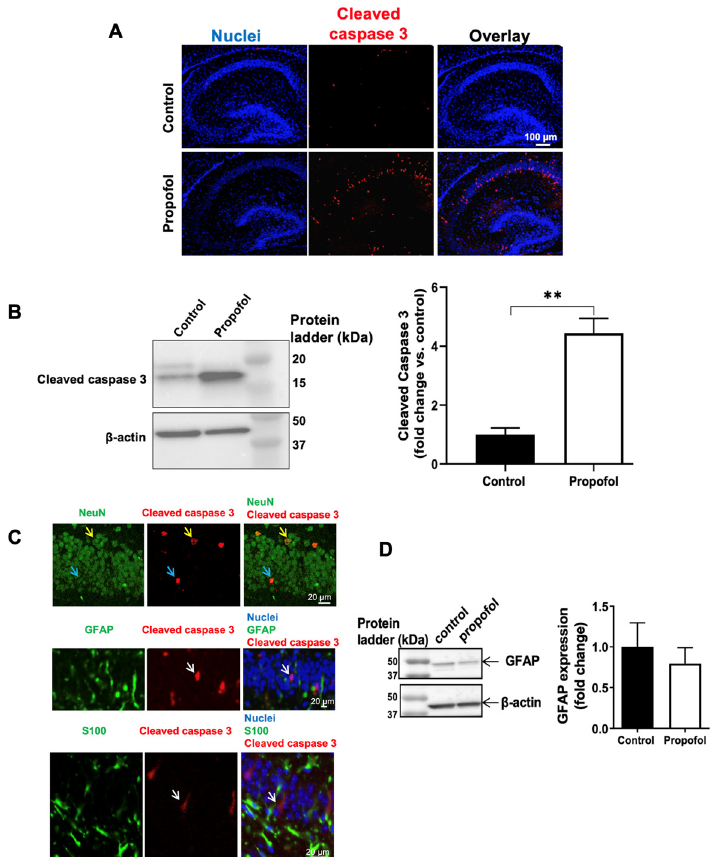
Figure 1. Neuroapoptosis in postnatal day 7 (P7) mouse hippocampi was induced by propofol. ( A ) Immunofluorescent staining and imaging showed that 6 h-propofol exposure at P7 induced acute cleaved caspase 3-positive apoptotic cells in mouse hippocampal tissue. Blue are cell nuclei and red are cleaved caspase 3-positive apoptotic cells. Scale bar = 100 µ m. ( B ) The propofol-induced apoptosis was further confirmed and quantified by Western blot. n = 4, ** p < 0.01. ( C ) Propofol exposure led to apoptosis in neurons but not astrocytes in the hippocampus. The cleaved caspase 3-positive apoptotic signals (red) were located in neuronal nuclear antigen (NeuN; neuron marker)-positive neurons (green) but not in glial fibrillary acidic protein (GFAP) and S100 (astrocyte marker)-positive astrocytes. Blue are cell nuclei stained with Hoechst 33342. Two representative apoptotic neurons are indicated by yellow and blue arrows. Non-astrocyte apoptotic cells are indicated by white arrows. Scale bar = 20 µ m. ( D ) Propofol exposure for 6 h did not alter the GFAP expression in hippocampal tissue. n =